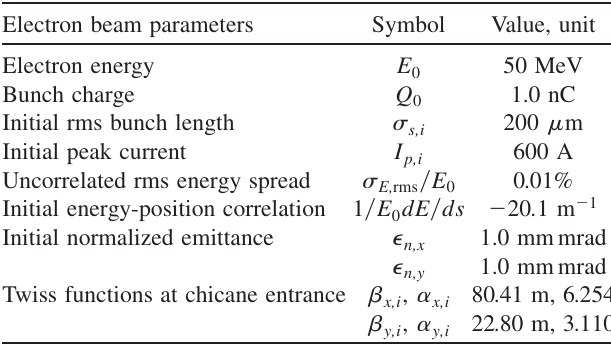
TABLE III. Electron beam parameters. The initial charge dis- tributions are Gaussian in all six dimensions.